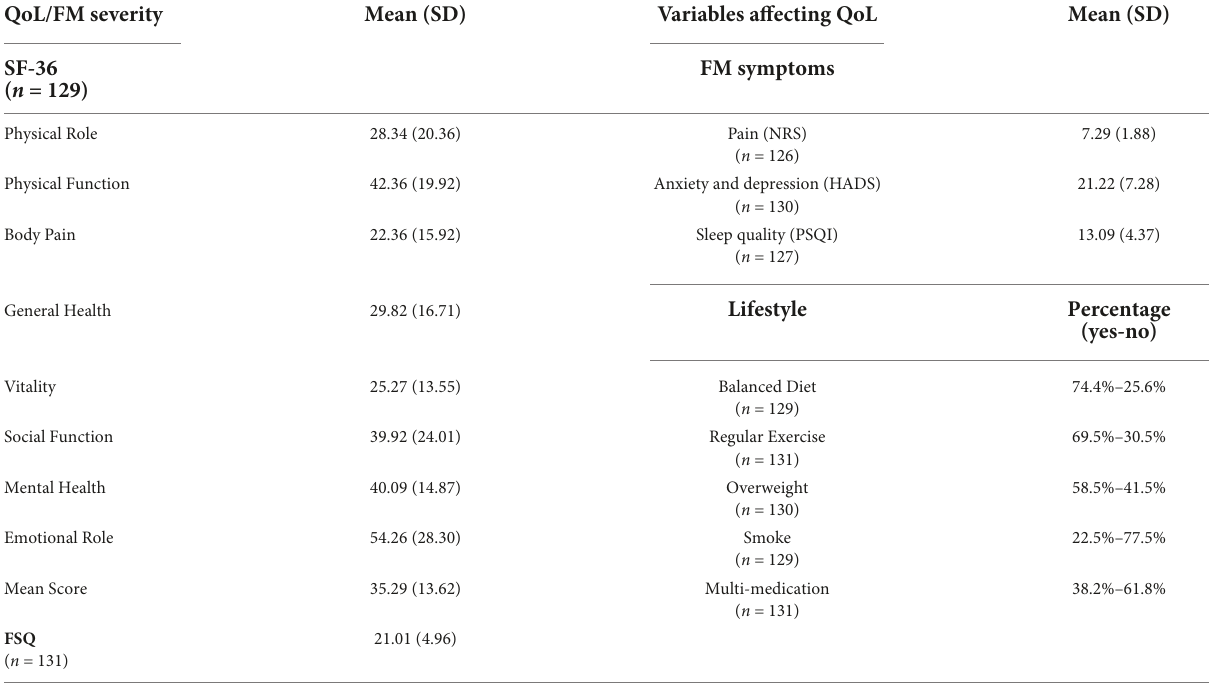
TABLE 1 Descriptive statistics of questionnaires of quality of life (QoL) (SF-36 subscales and global mean score), and Fibromyalgia severity (FSQ), as well as of the different variables considered as factors of influence on QoL.